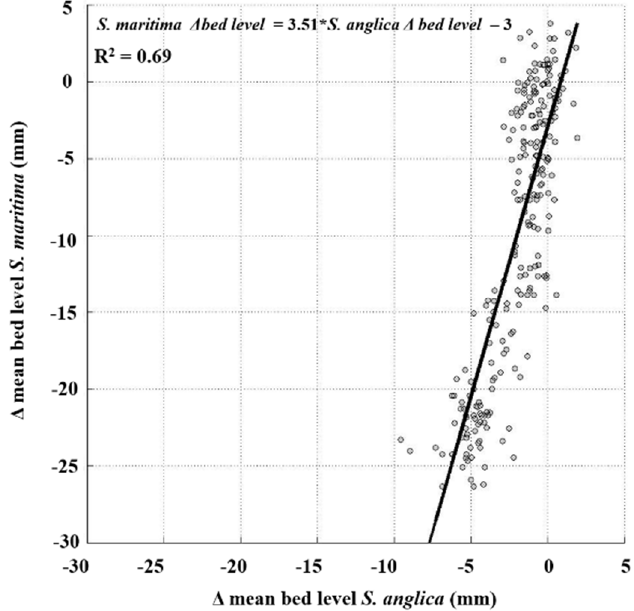
Figure 7. Bed level variation (in mm) within Spartina maritima versus variations within Spartina anglica vegetation. Bed level variations are tidally averaged values. Negative values indicate erosion, and positive values indicate accretion. Black line corresponds to linear regression expressed by the equation y = 3.51x − 3 (R 2 = 0.83, n = 235, p < 0.001, with significance threshold at p = 0.05).